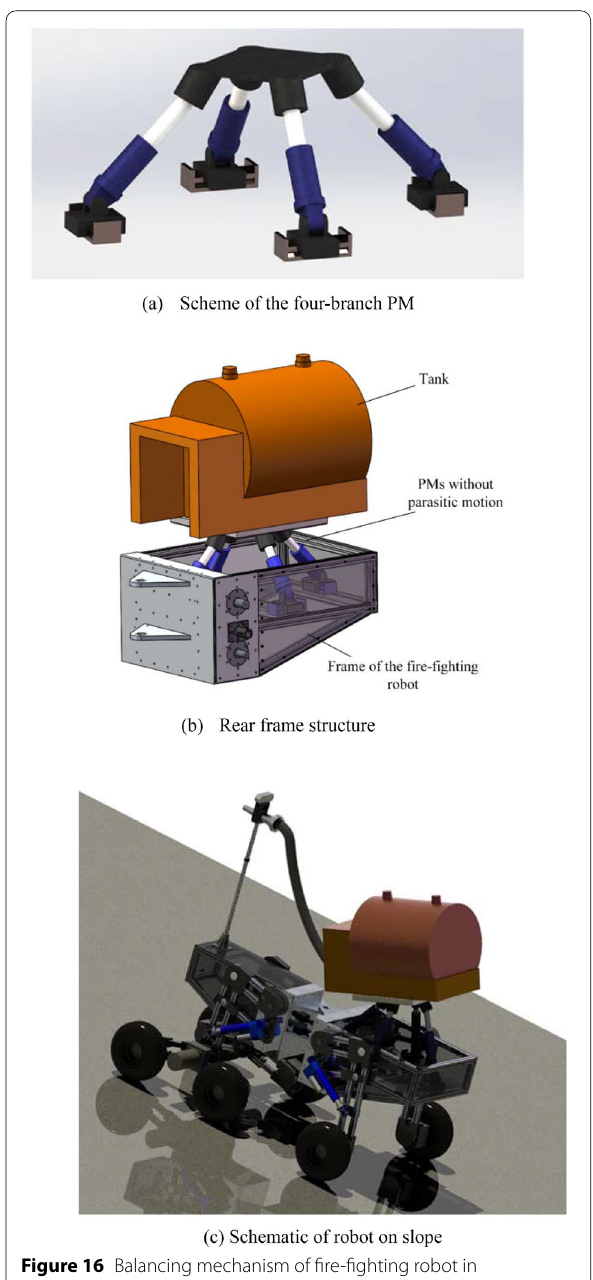
Figure 16 Balancing mechanism of fire-fighting robot in rough-terrain based on 4-PRPS